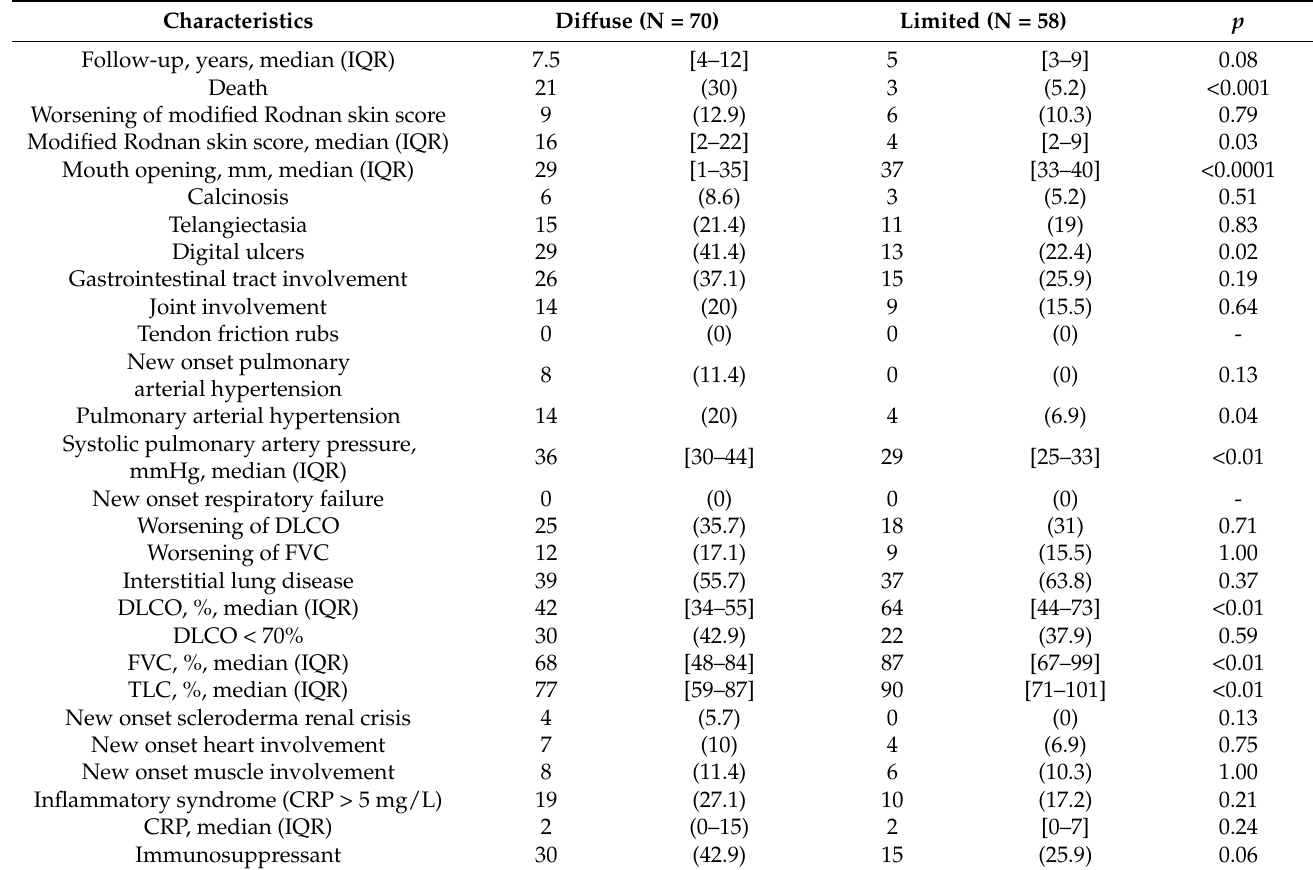
Table 6. Characteristics of patients with anti-topoisomerase 1 antibodies at last